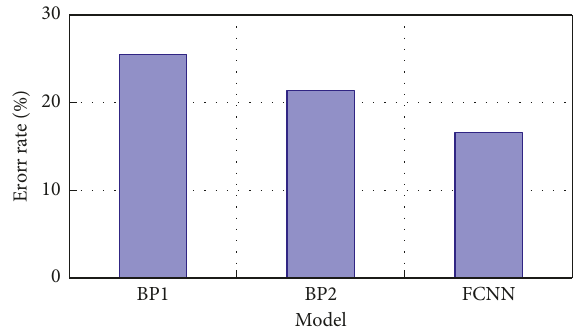
Figure 10: Error rate of different recognition models.